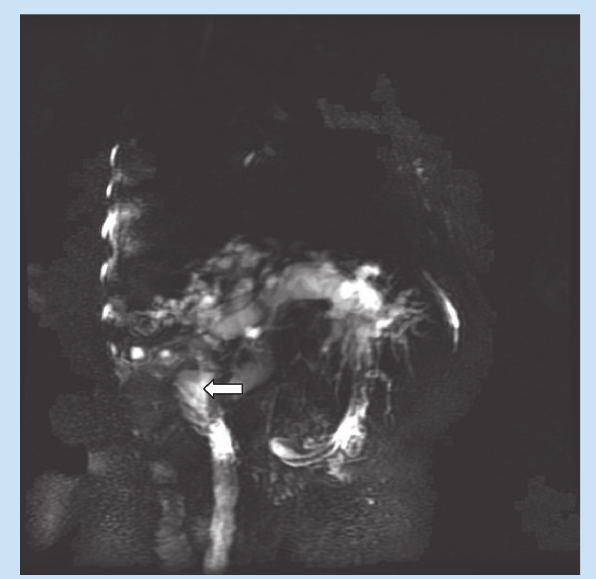
Fig. 2. High-resolution thick slab long TE 1 100 ms (rotated to RAO posi- tion) MRCP demonstrating a stone impacted in the common bile duct (white arrow).